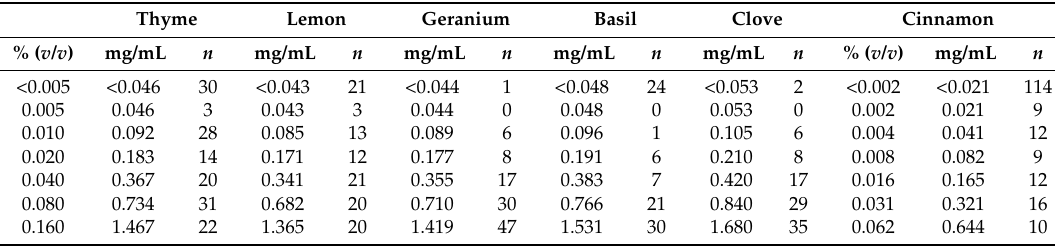
Table 1. Number of isolates with exact MIC value of the selected essential oil in the group of 183 C. albicans clinical